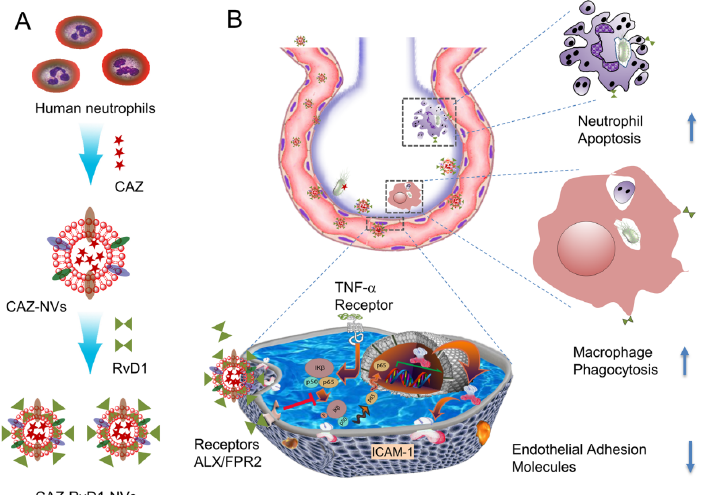
Figure 8. ( A ) shows the generation of neutrophil membrane-derived nanovesicles (NVs) co-loaded with RvD1 and Ceftazidime (CAZ). ( B ) The nanovesicles home to the infectious lung deliver both RvD1 and CAZ. RvD1 binds to GPCRs (ALX/FPR2), inhibiting the NF- κ B pathway to decrease the expression of cell adhesion molecules, and mitigating neutrophil tissue infiltration and increasing the phagocytosis. Simultaneously, CAZ inhibits bacterial growth in the lung. Modified and reproduced with permission from the Spring [98].